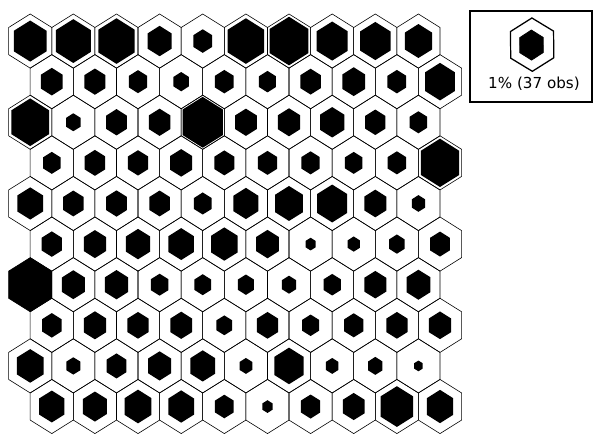
Fig. 4. Frequency of occurrence of the SOM patterns. The area of the black hexagons inside each neuron is proportional to the fre- quency of the pattern it